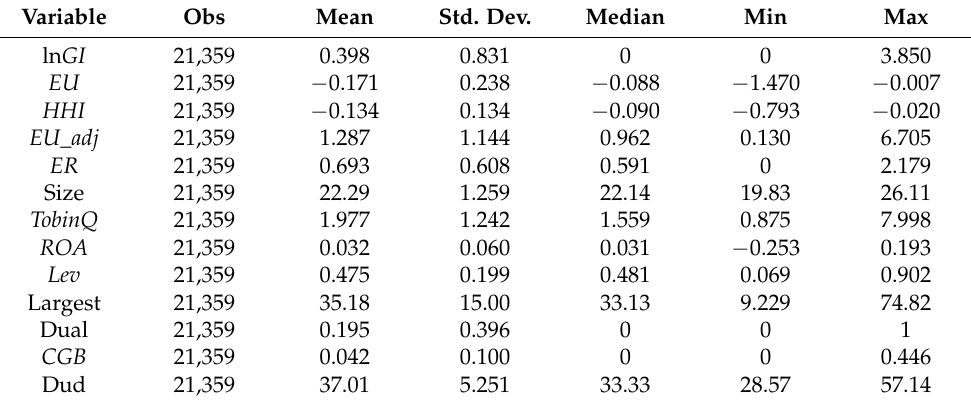
Table 2. Descriptive statistics of each